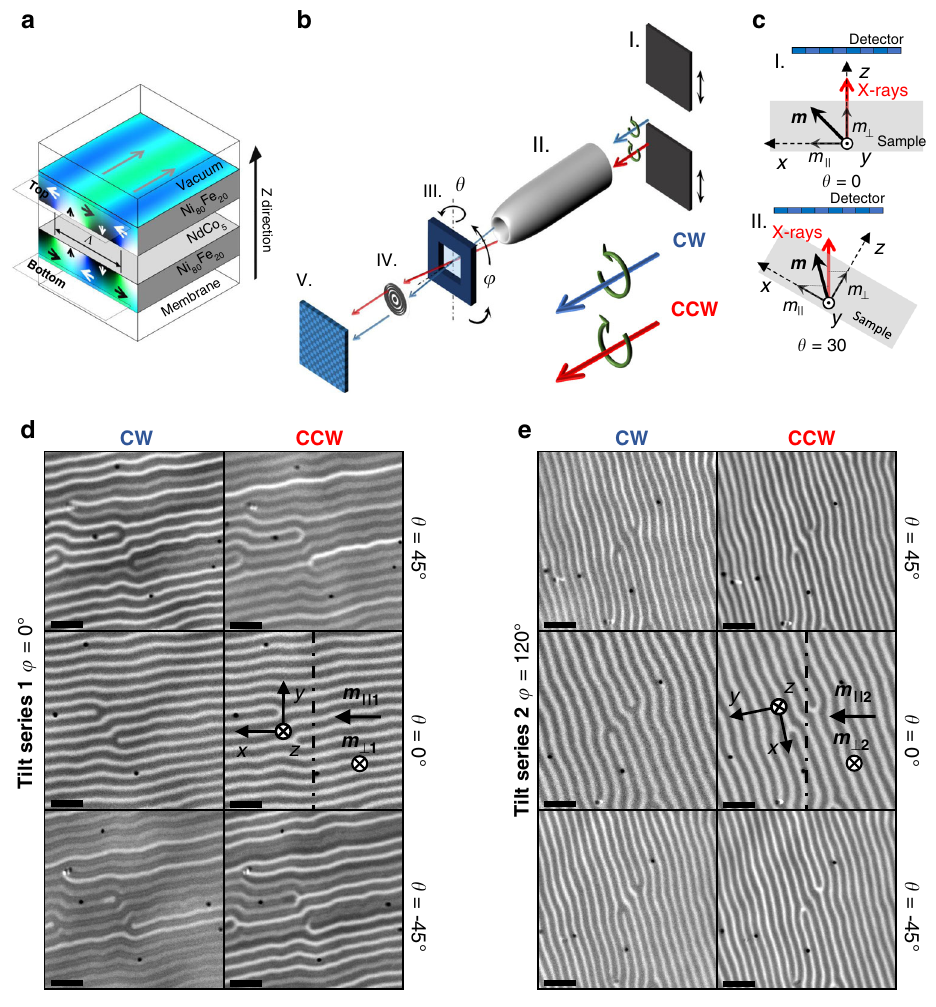
Fig. 1 Sample sketch, experimental set up, and Tilt series image data. a Sketch of magnetization in the striped domain pattern in NiFe/NdCo/NiFe trilayer. b Scheme of the full- fi eld magnetic soft X-ray transmission microscope: (I) ancillary slits to select the polarization of the X rays (circular CW or CCW), (II) capillary condenser, (III) goniometric stage ( θ rotation), φ rotation manually performed outside the microscope, (IV) Fresnel zone plate, and (V) CCD detector. c Top view sketch to illustrate sample reference frame and magnetization components probed during a θ rotation (around the y axis): (I) Normal incidence ( θ = 0°) leads to out-of-plane ( m ⊥ ) sensitivity. (II) Oblique incidence ( θ = 30°) allows for in-plane ( m || ) and out-of-plane ( m ⊥ ) sensitivity. d , e Transmittance images for two different sample con fi gurations, incidence angles, and photon polarizations: d Tilt series 1 ( φ = 0°), e Tilt series 2 ( φ = 102°). Reference frame indicated in both datasets. Probed magnetization components ( m || , m ⊥ ) indicated for each con fi guration. Dot – dash vertical line indicates θ rotation axis. Scale bars 1 μ m. The black dots in the images of d and e are Au fi ducials for